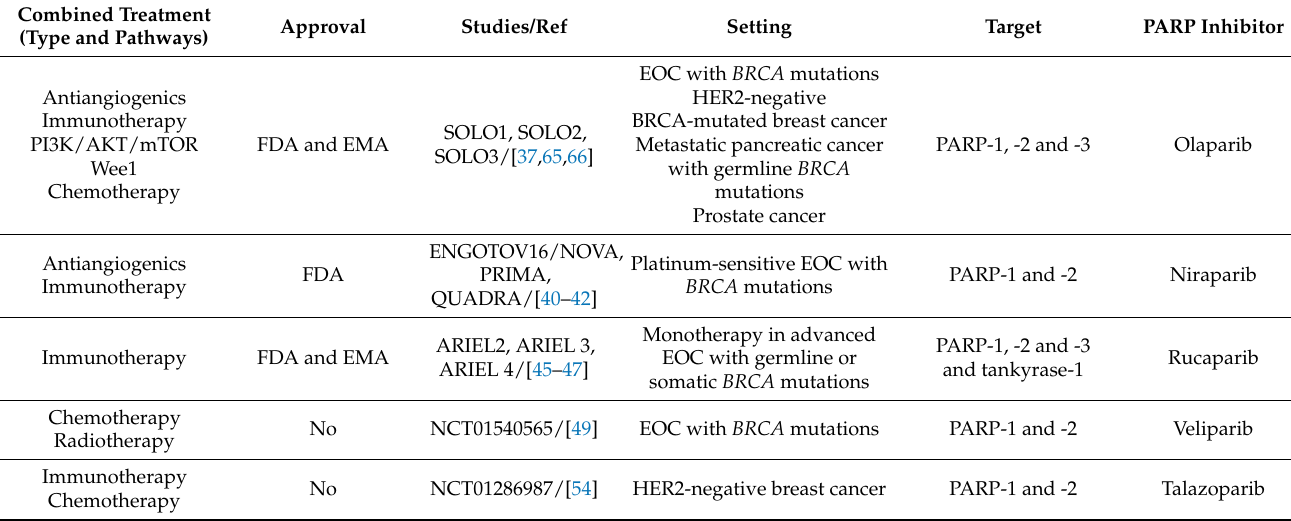
Table 1. Poly(ADP-ribose) polymerase (PARP) inhibitors trials in